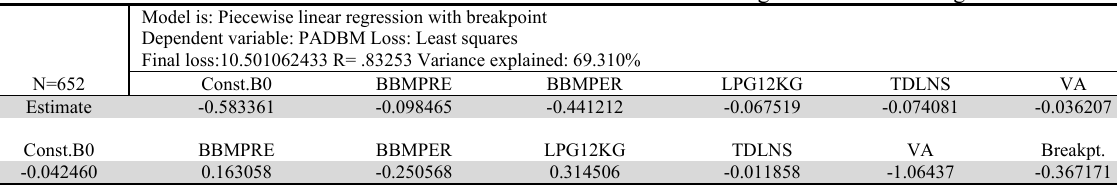
The result of five disturbance variables affect economic resilience variable Z using Piecewise linear regression Model is: Piecewise linear regression with breakpoint Dependent variable: PADBM Loss: Least squares N=652